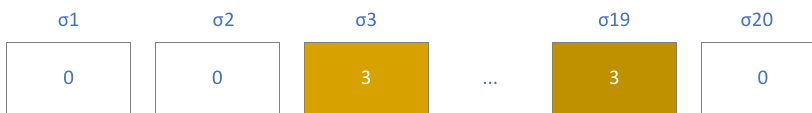
Figure 4. The difference between the satellite number of the task at a certain moment and the satellite number of the task at the initial time, if it is 0, it means that the task has not been scheduled to other satellites, if it is not 0, it means that the task has been scheduled to other